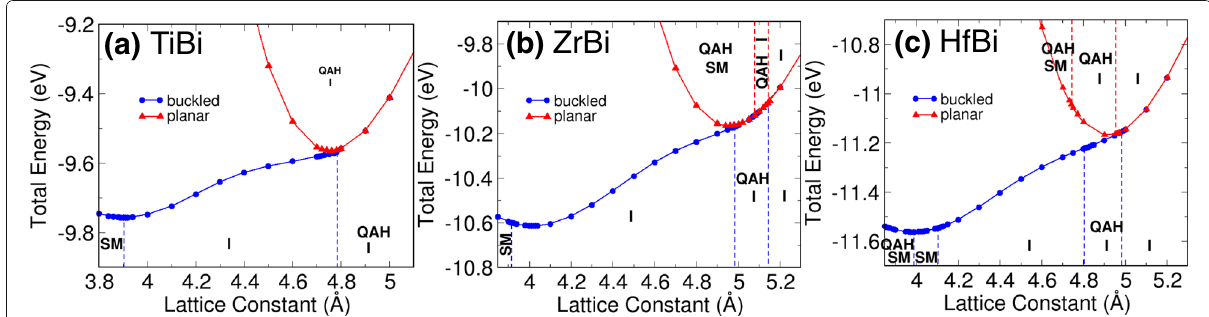
Fig. 2 Phase diagram of a TiBi, b ZrBi, and c HfBi showing the total energy at different lattice constants. The diagram is divided into various regions labeled as QAH (quantum anomalous Hall phase), I (insulator), and SM (semi-metal). Blue circles and red triangles represent buckled and planar cases, respectively